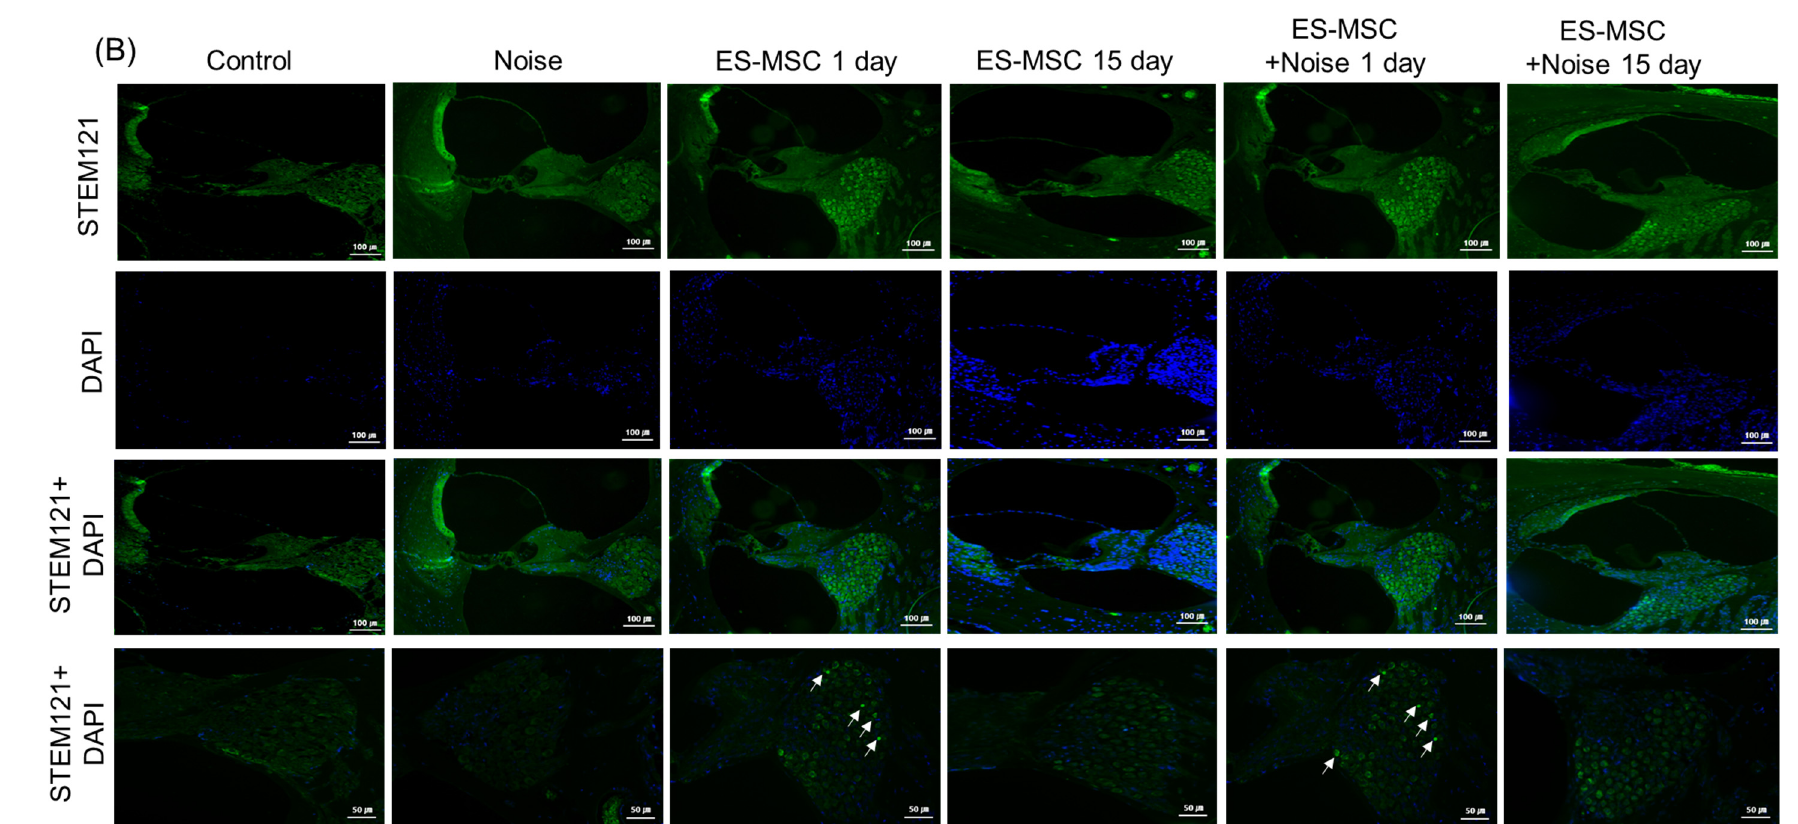
Figure 4. Human DNA detection in ES-MSC+noise rats. ( A ) Human Sry gene PCR (2 cochleae or 2 rats for each group) demonstrated Sry bands in cochlear and lung tissues 1 day and 15 days after ES-MSC administration. Red arrow indicates the Sry band. ( B ) Human cytoplasmic protein examination using STEM121 immunofluorescence staining (2 cochleae for each group) demonstrated a scant number of STEM121-positive cells in the spiral ganglial area in ES-MSC 1-day and ES-MSC+noise 1-day rats. White arrows indicated the STEM121-positivity in the spiral ganglial area. (scale bar (B) 100 µm, 50 µm) Because there were no implanted ES-MSCs in the outer or inner hair cells, the otoprotective role of secreted molecules, such as